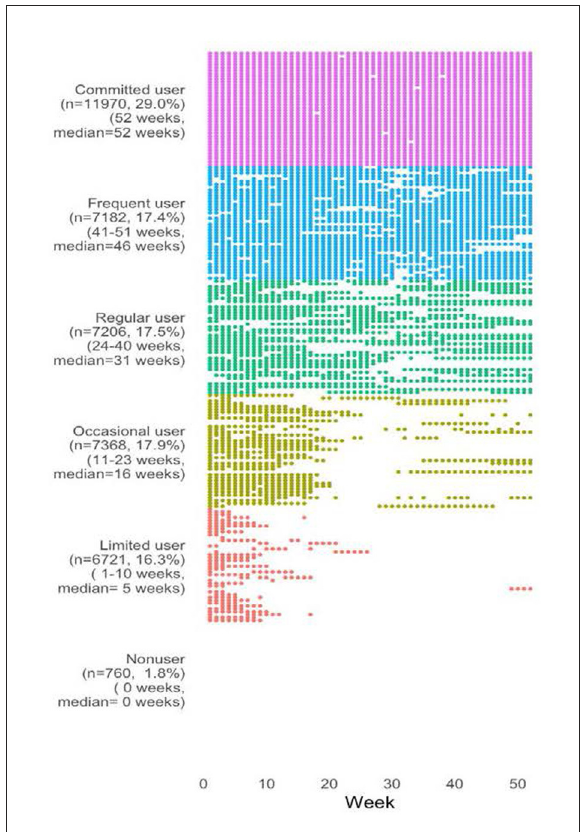
FIGURE1 Weeks in use by usage group. Forty users are randomly sampled from each usage group. The plot shows the actual weeks in